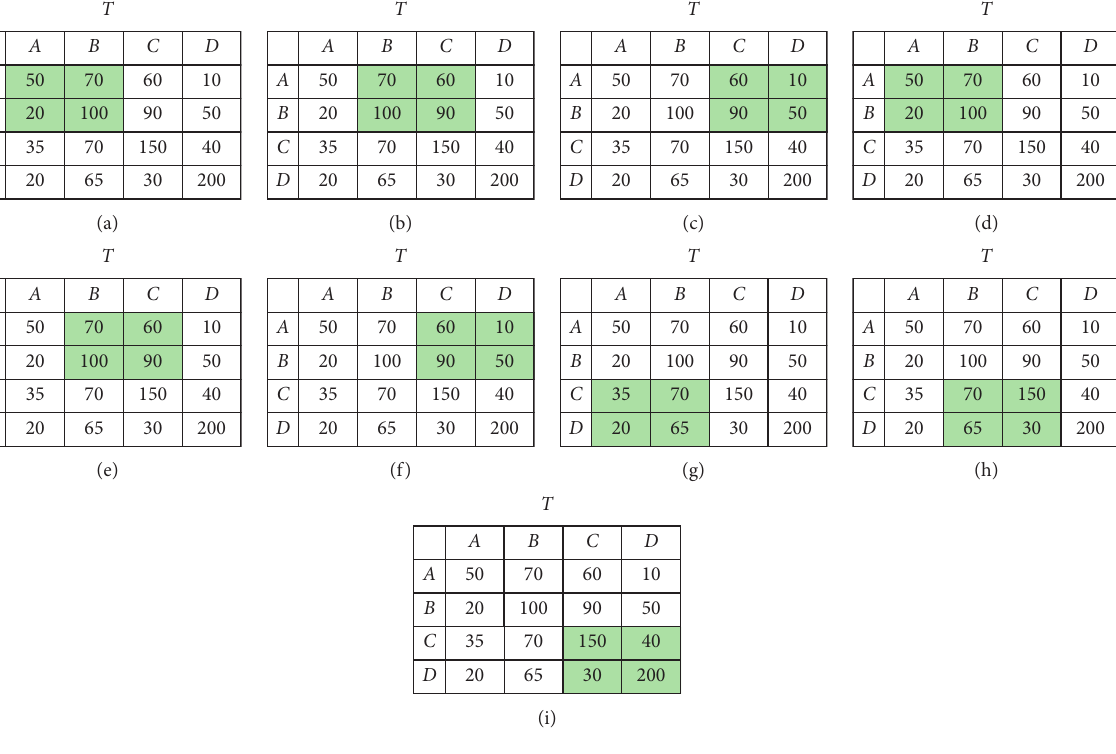
Figure 2: Creation and movement of a 2 × 2 window in a matrix.